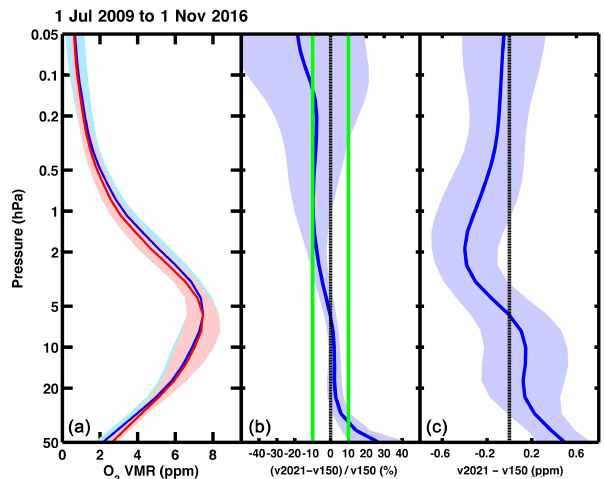
Figure 1. Mean ozone profiles retrieved by version 2021 (red line in panel (a) ) and by version 150 (blue line in panel (a) ) measured by GROMOS during the period from July 2009 to November 2016. The blue area (v150) and the red area (v2021) are the SDs of the ozone VMR. The mean relative difference profile (blue line) and the SD of the differences (blue area) are represented panel (b) , using the new version as reference. The green line delimits the ± 10% area. The VMR difference profile along with its SD are shown in panel (c) .